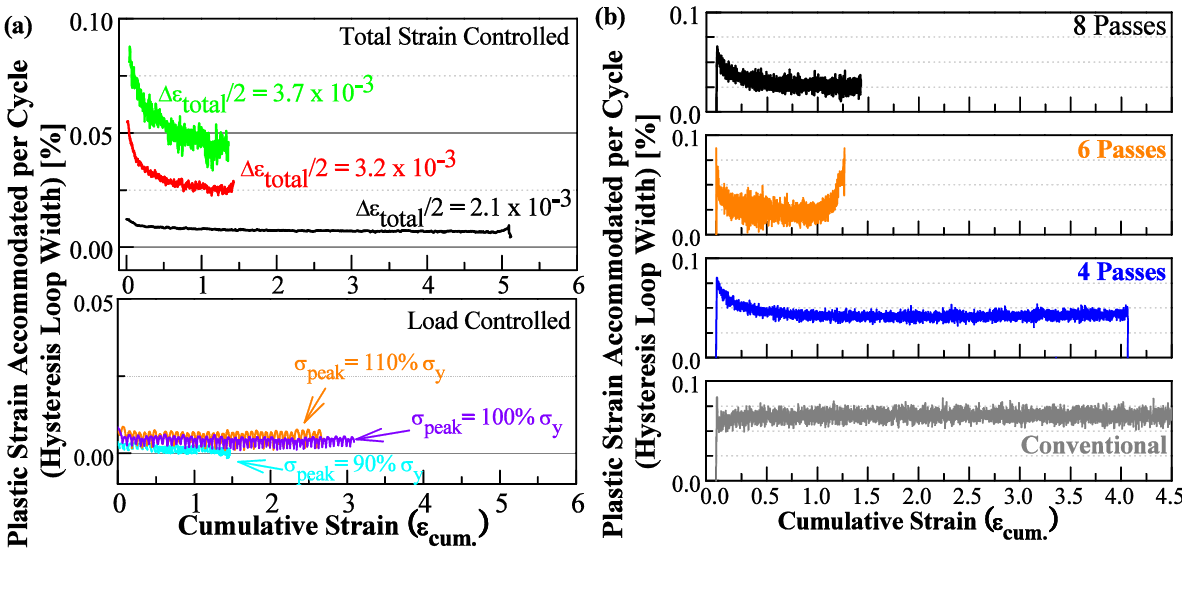
/2 = 3.2 × 10 −3 total